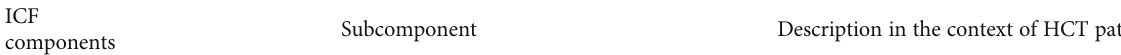
Table 1: Example of HCT impact on a patient according to the ICF classi fi